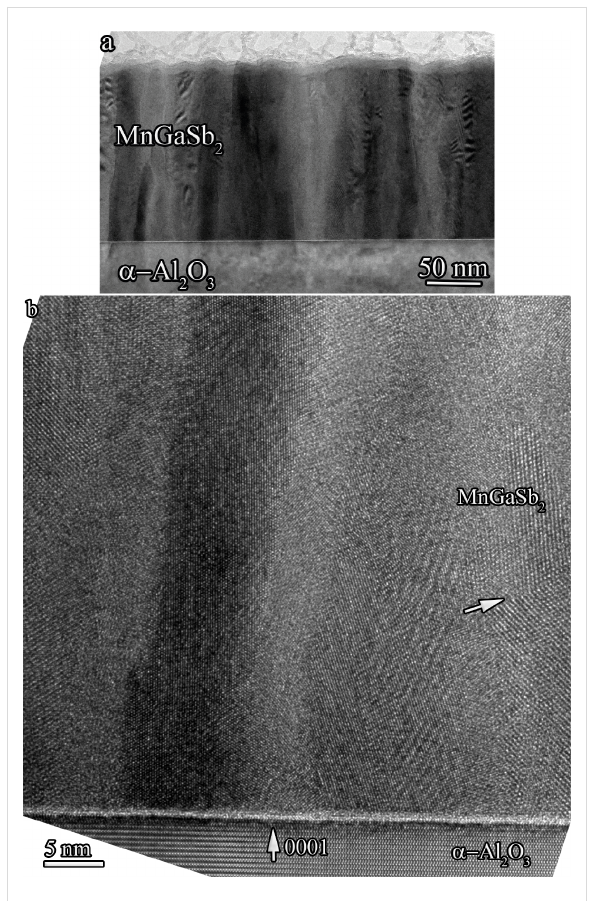
Figure 4: TEM images of the film cross section after annealing (sam- ple GM3): (a) bright-field image, (b) HRTEM image.